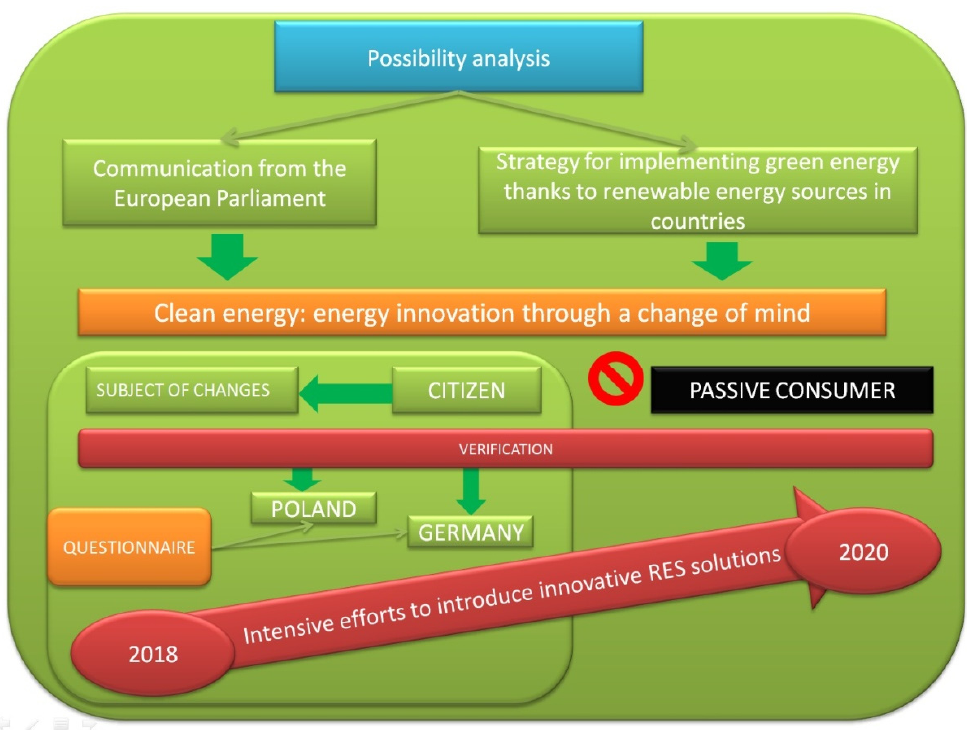
Figure 17. The adopted strategy of the performed analysis.